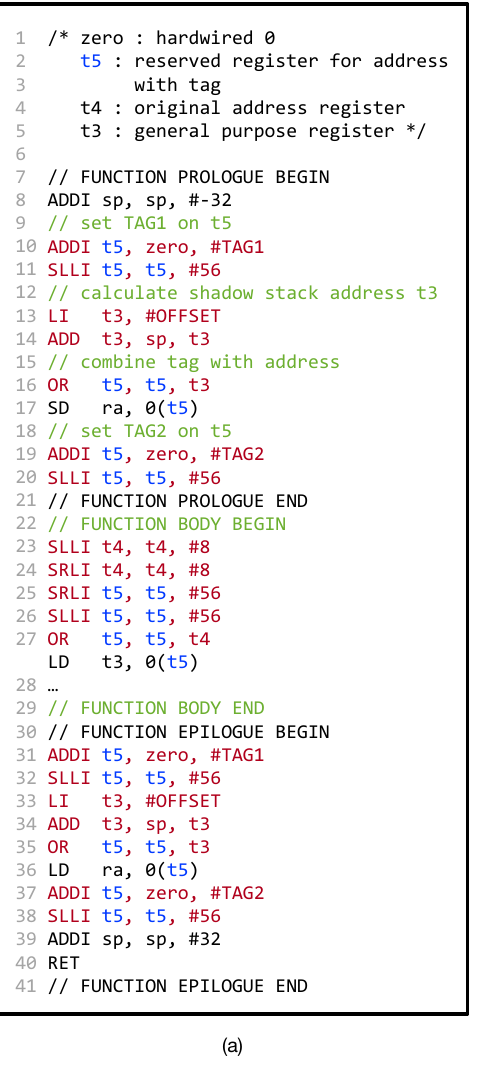
Figure 7. Shadow stack and In-process isolation in TME: ( a ) pseudo code of shadow stack in TME and ( b ) pseudo code of in-process isolation in